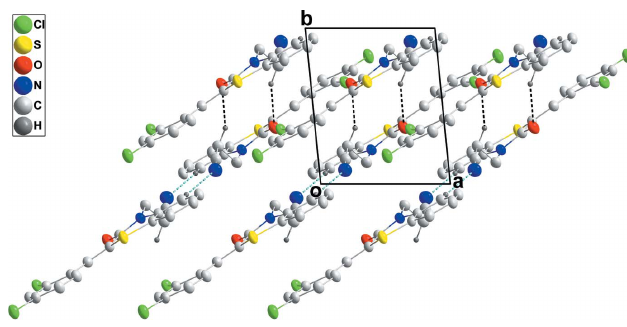
Figure 2 A partial packing diagram viewed along the c -axis direction with the